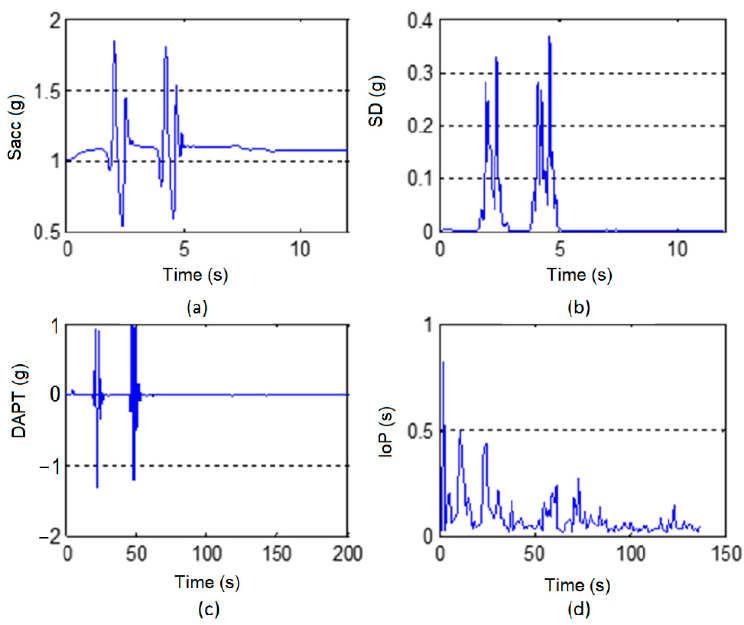
Figure 14. Diagram of features in D11: ( a ) Sacc over time; ( b ) SD over time; ( c ) DAPT over time; ( d ) IoP over time.